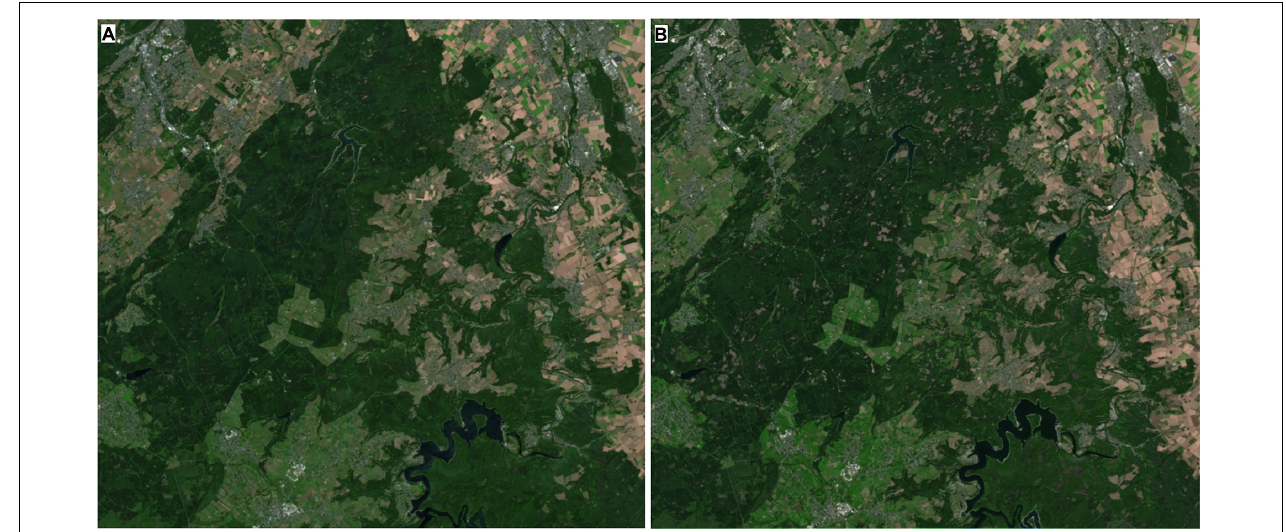
FIGURE 5 | Sentinel-2 July/August median composite (RGB = B4, B3, and B2) (A) for the year 2018, and (B) for the year 2020 (CDF-matched).